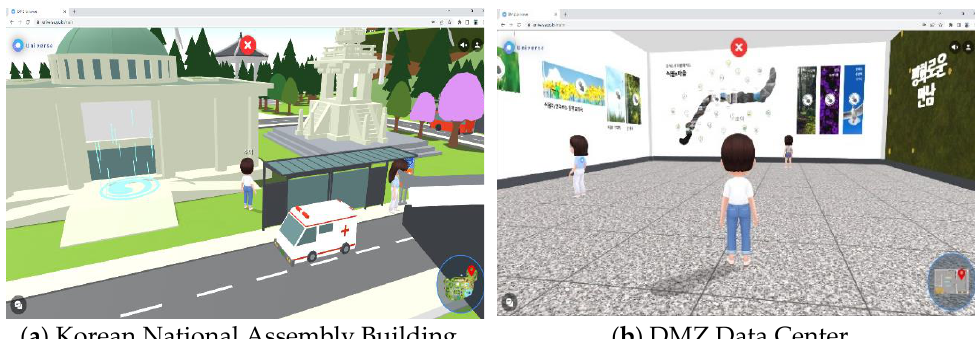
Figure 11. DMZ Actual Condition Data.